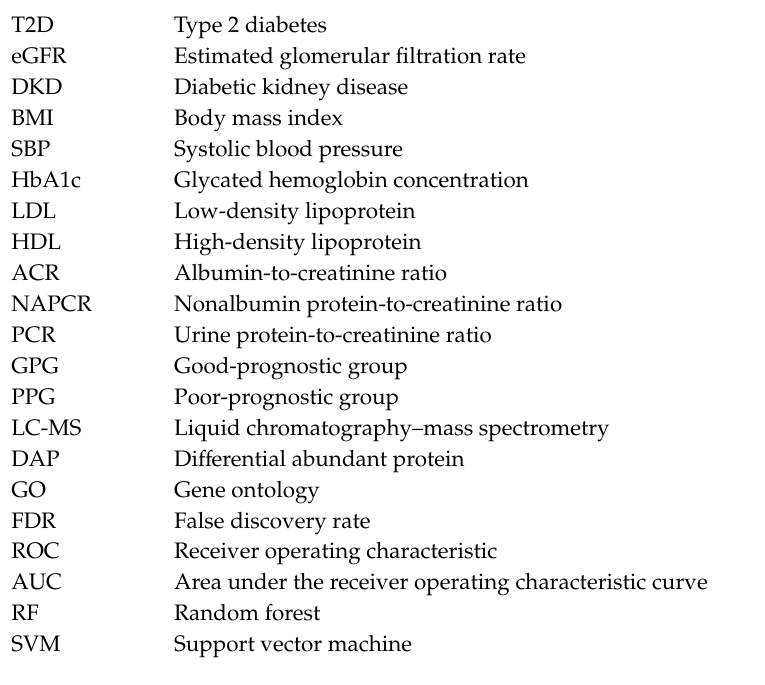
Table S5. Univariate receiver operating curve analysis of the areas under the curves of 412 urinary proteins.; Table S6. Prognostic probability by RF and SVM classifier of 54